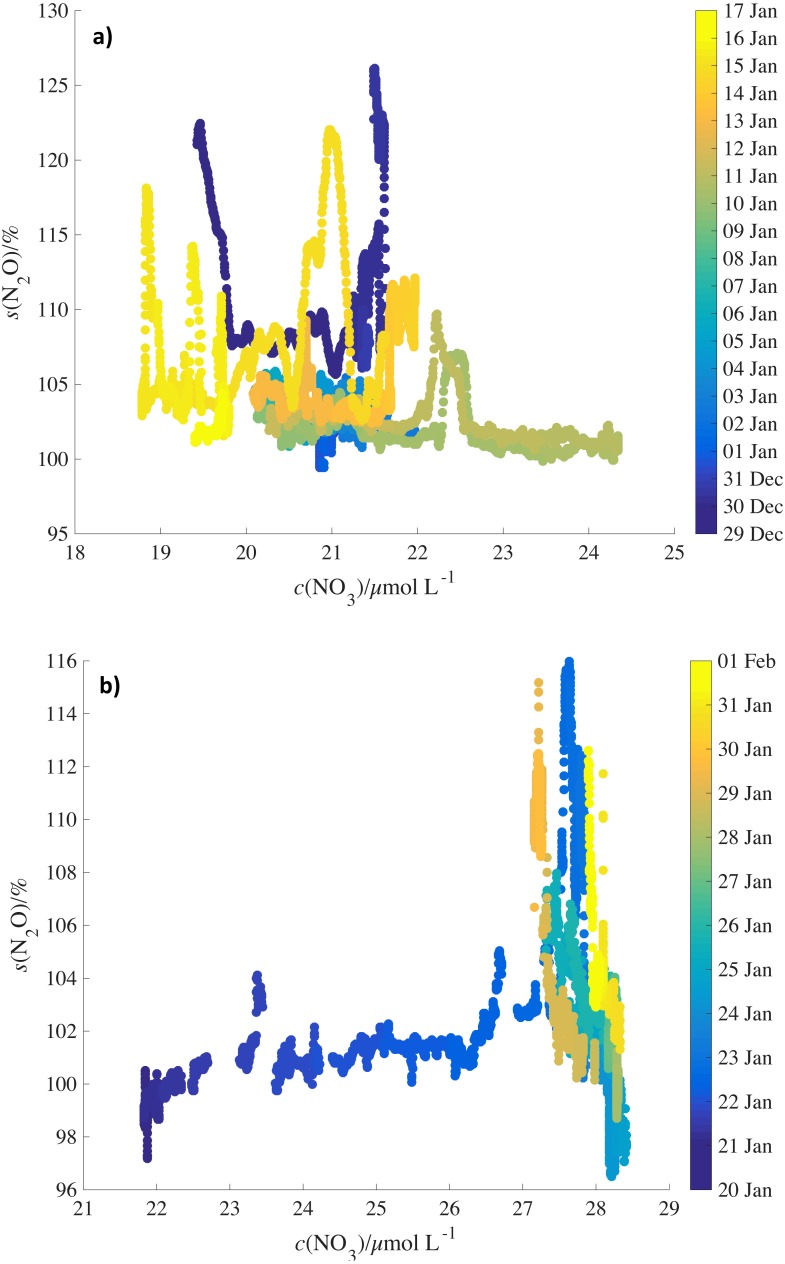
Relationship between N2O saturations and MLD NO\documentclass[12pt]{minimal}
\usepackage{amsmath}
\usepackage{wasysym}
\usepackage{amsfonts}
\usepackage{amssymb}
\usepackage{amsbsy}
\usepackage{upgreek}
\usepackage{mathrsfs}
\setlength{\oddsidemargin}{-69pt}
\begin{document}
}{}${}_{3}^{-}$\end{document}3− concentrations by date.N2O saturations (A) during JR260B and (B) JR255A/GENTOO plotted against mean winter MLD NO\documentclass[12pt]{minimal}
\usepackage{amsmath}
\usepackage{wasysym}
\usepackage{amsfonts}
\usepackage{amssymb}
\usepackage{amsbsy}
\usepackage{upgreek}
\usepackage{mathrsfs}
\setlength{\oddsidemargin}{-69pt}
\begin{document}
}{}${}_{3}^{-}$\end{document}3− concentrations from World Ocean Atlas. Symbols are colour-coded for date.